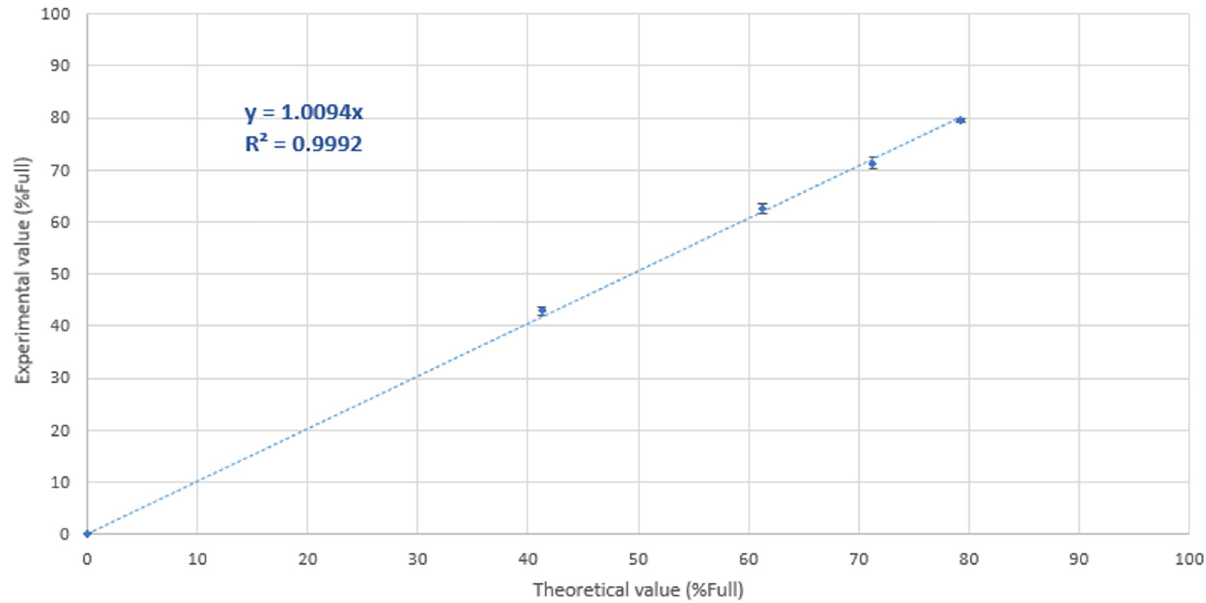
Fig 4. Relation between the theoretical filled values and the obtained experimental data. Each data point from the plot corresponds to the mean value of twelve repeats ( cf . S3 Table), with the error bars corresponding to the standard deviation of each population.